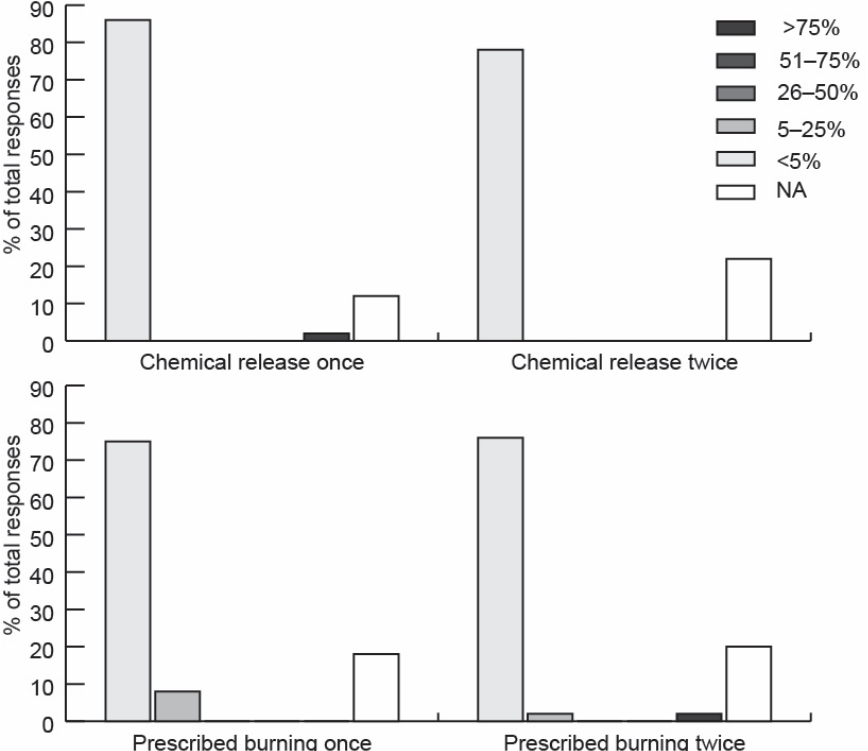
Figure 5. The survey respondents’ reported mid-rotation forest management practices conducted in hardwood stands in Georgia.